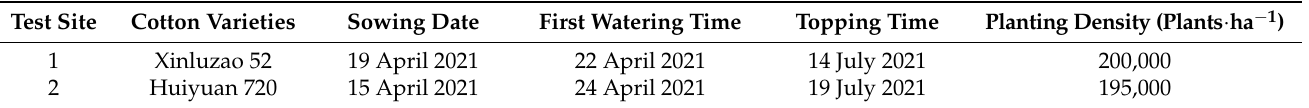
Figure 1. The graphical map of the study area. Table 1. Planting overview of the test sites.